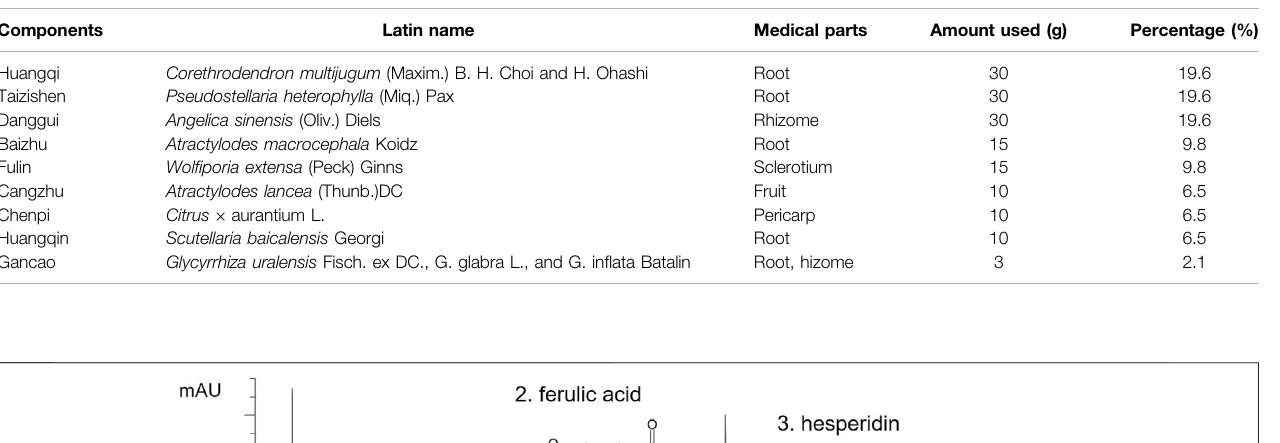
Frontiers in Pharmacology |